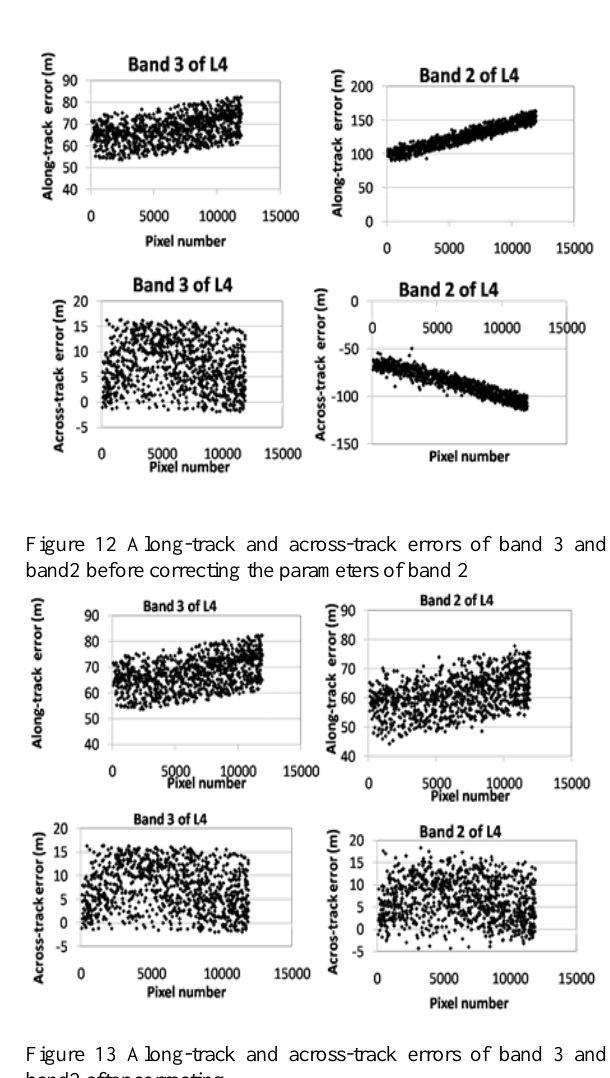
Figure 13 Along-track and across-track errors of band 3 and band2 after